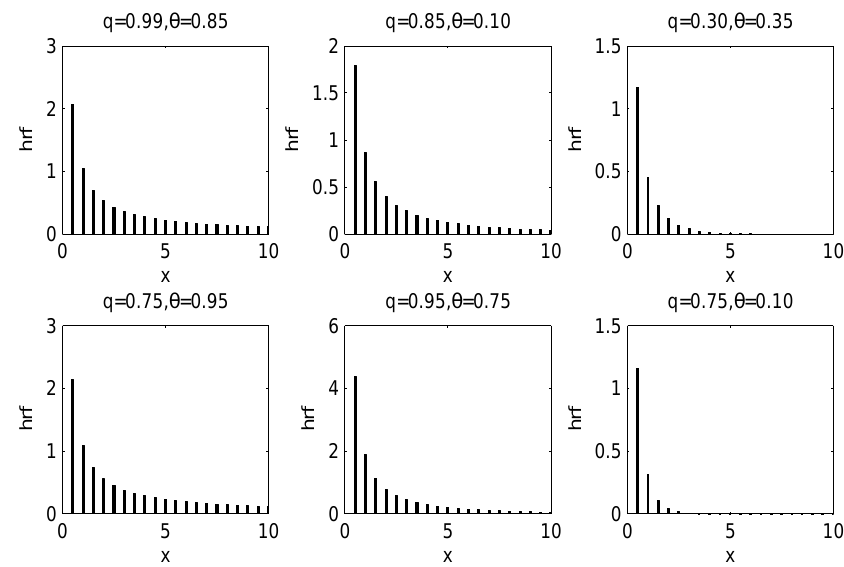
Figure 2. Plots of the hf of the TRTG distribution for some choices of q and θ